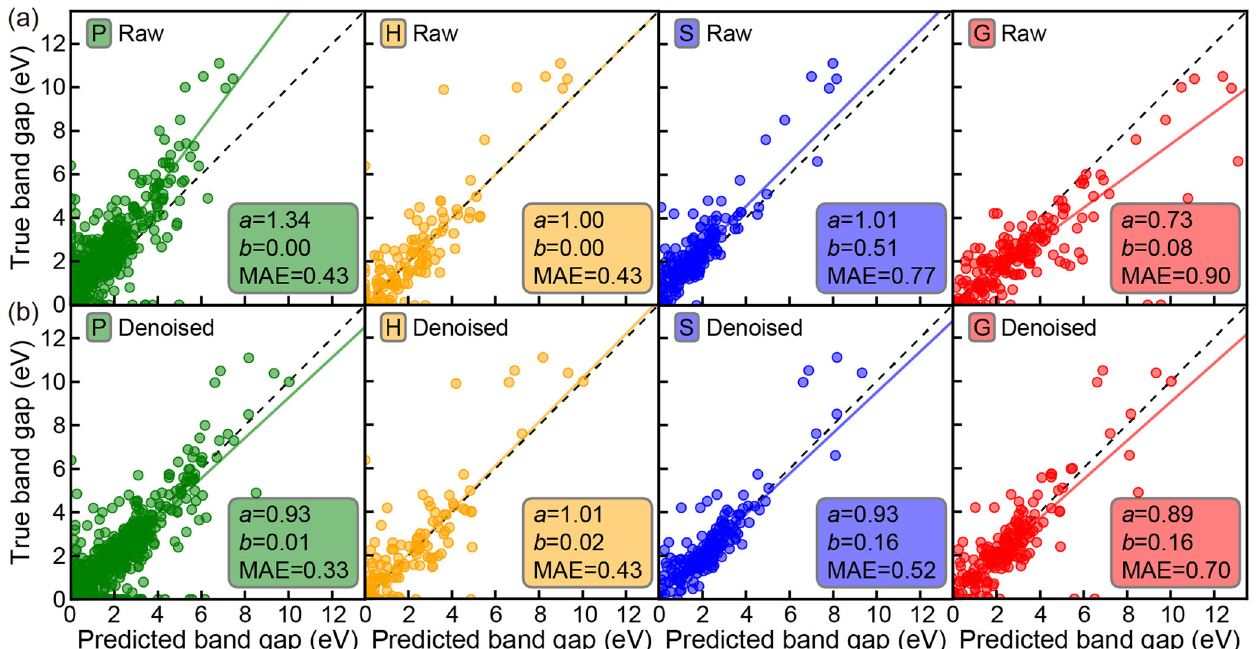
Fig. 1 True (i.e., experimental) vs. predicted band-gap parity plots. a The raw DFT data for different functionals (P, H, S, and G) and b the corresponding results obtained by applying the denoising procedure. A fi rst-order polynomial T = aP + b is used to fi t the true T and predicted P data points. The dashed line corresponds to a perfect match between P and T (i.e., a = 1, b = 0 with a null